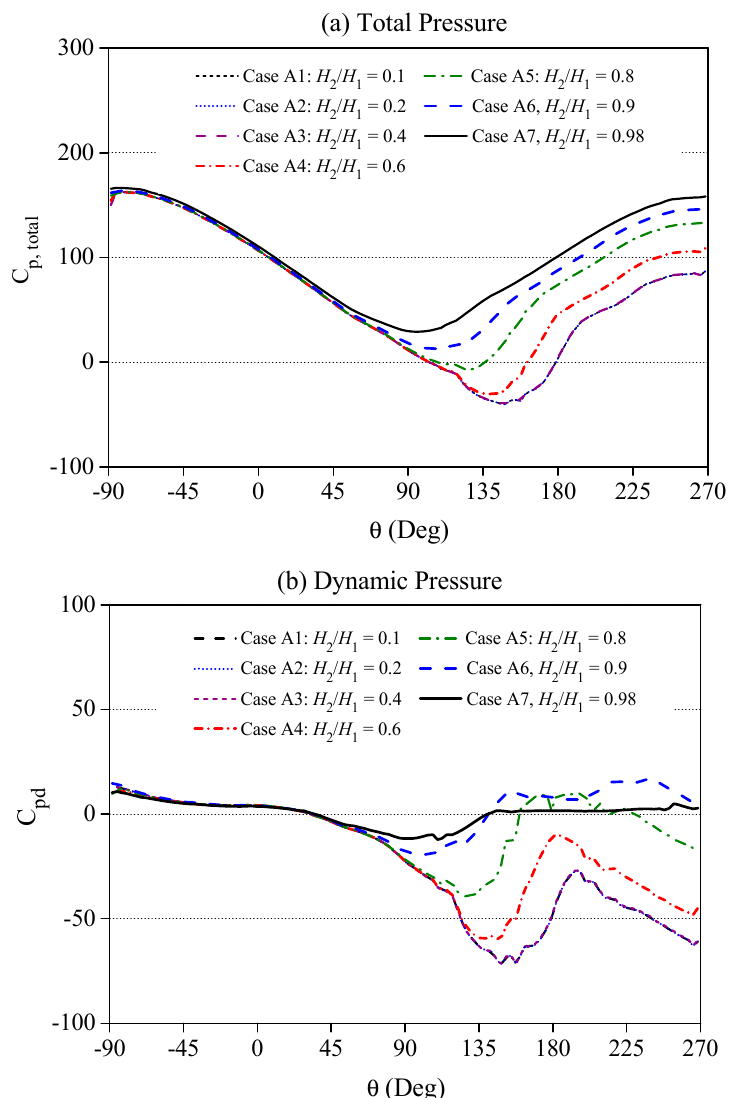
Figure 9. Pressure coefficients on the surface of the circular dam under different depth ratios. ( a ) Total pressure; ( b ) dynamic pressure.